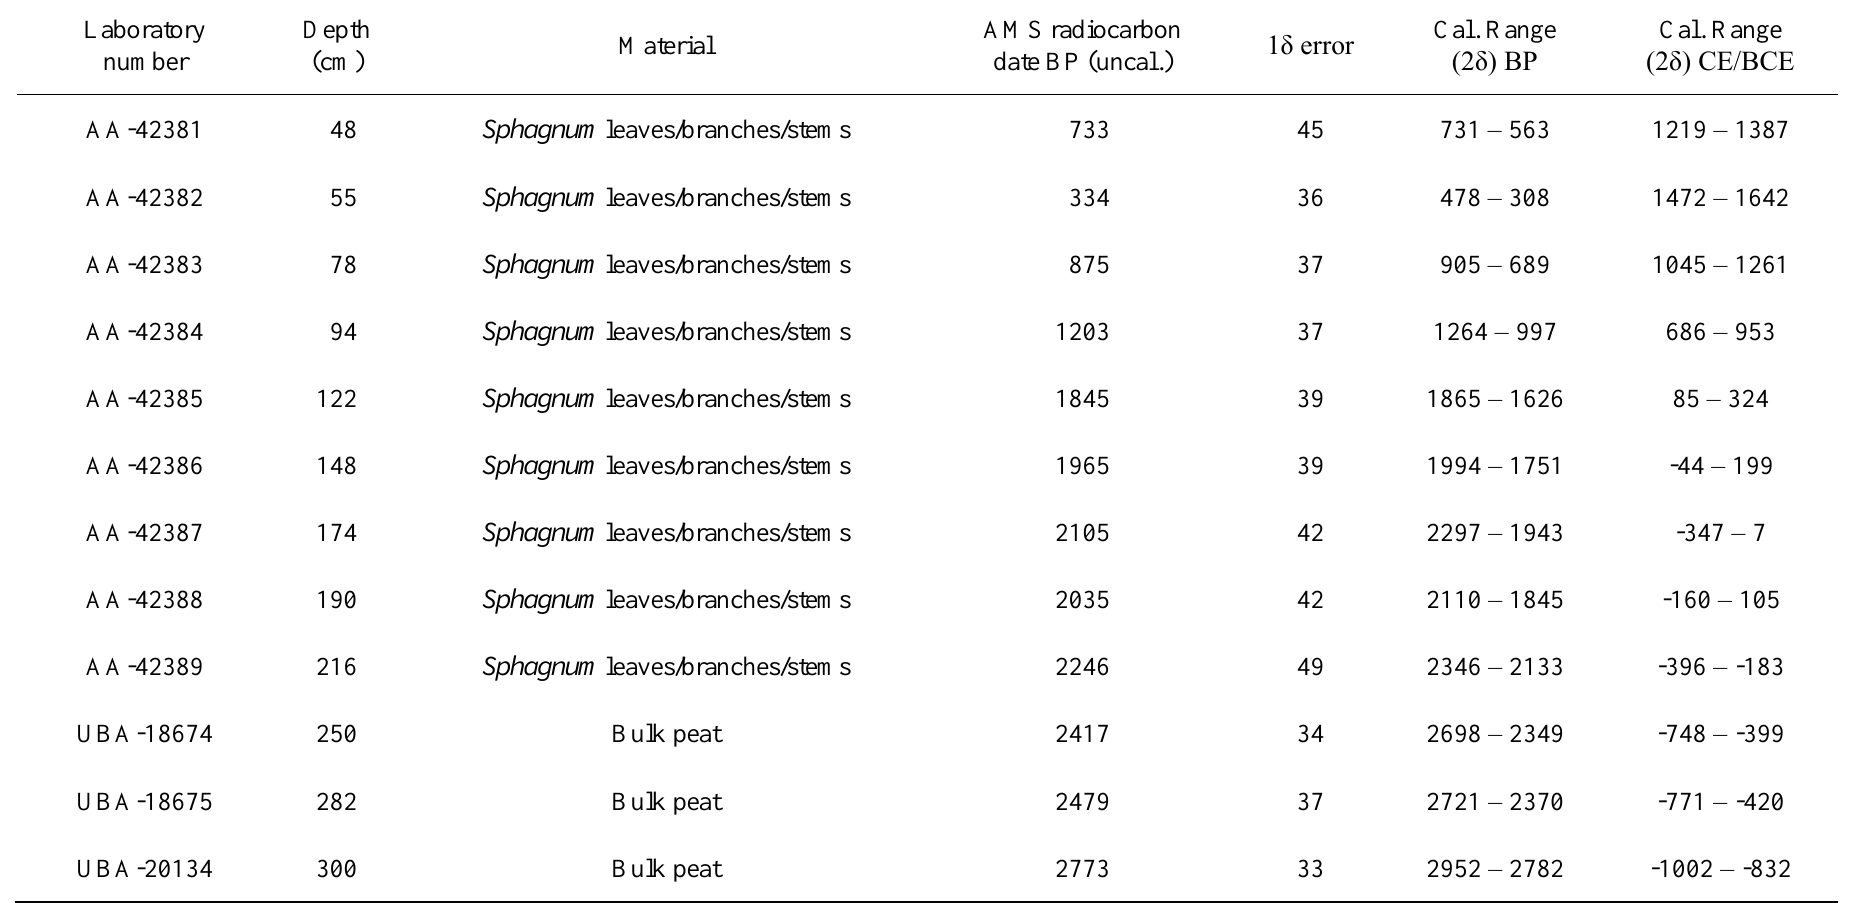
Table 1. AMS radiocarbon dates, calibrated (2δ